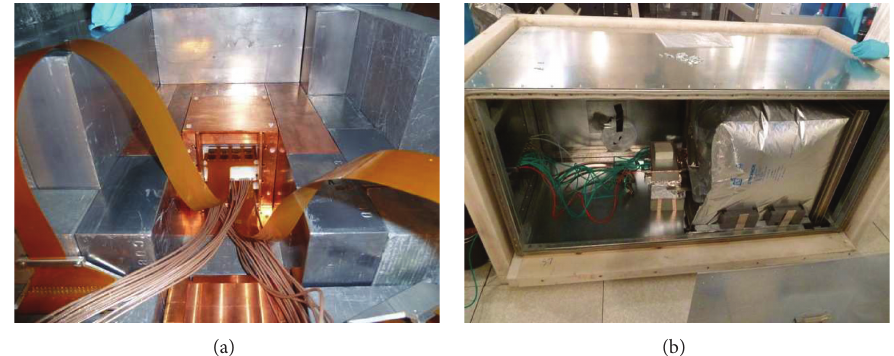
Figure 1: (a) Picture of the inner part of the setup showing the copper nest and the cable feedthrough surrounded by the lead and copper castle. (b) Picture of the whole setup with open EMI and neutron shielding showing the radon-tight foil containing the lead bunker.